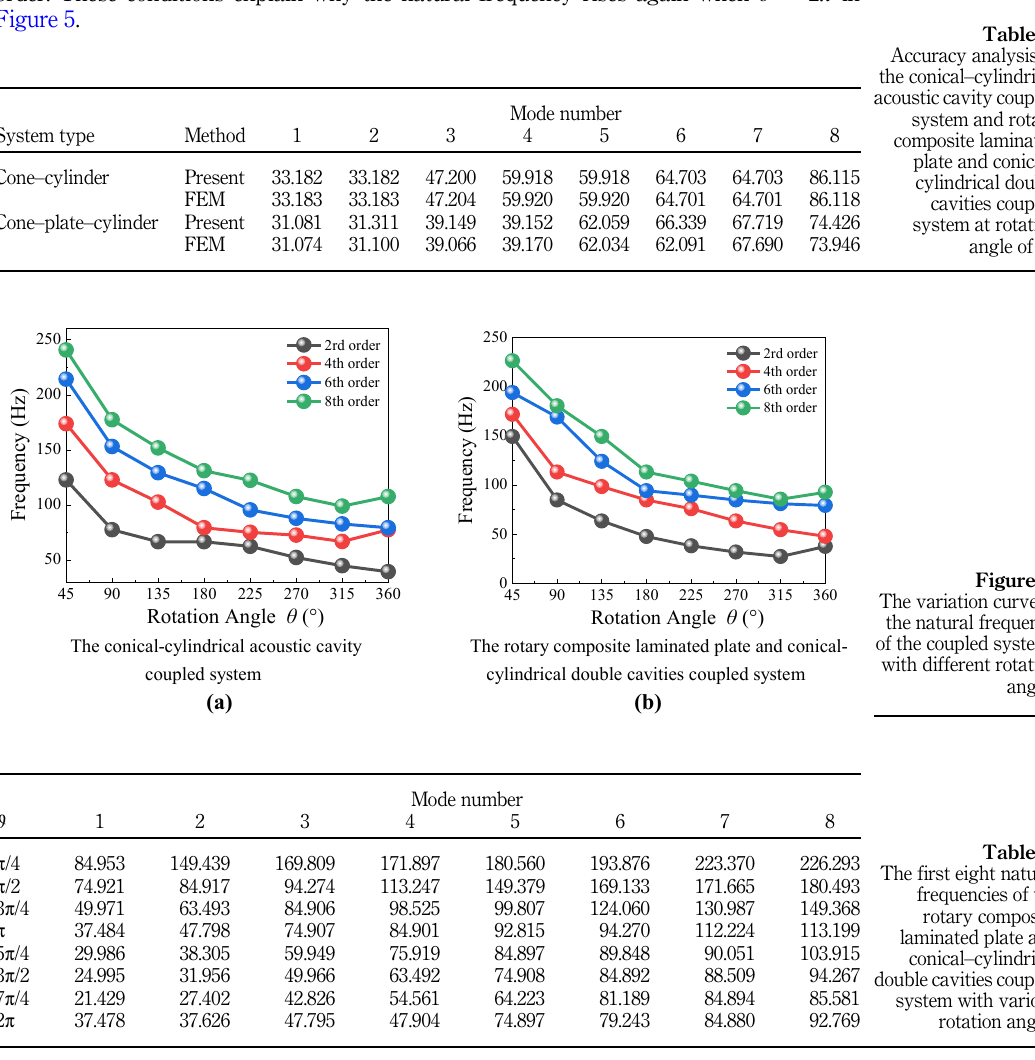
Table 7. The first eight